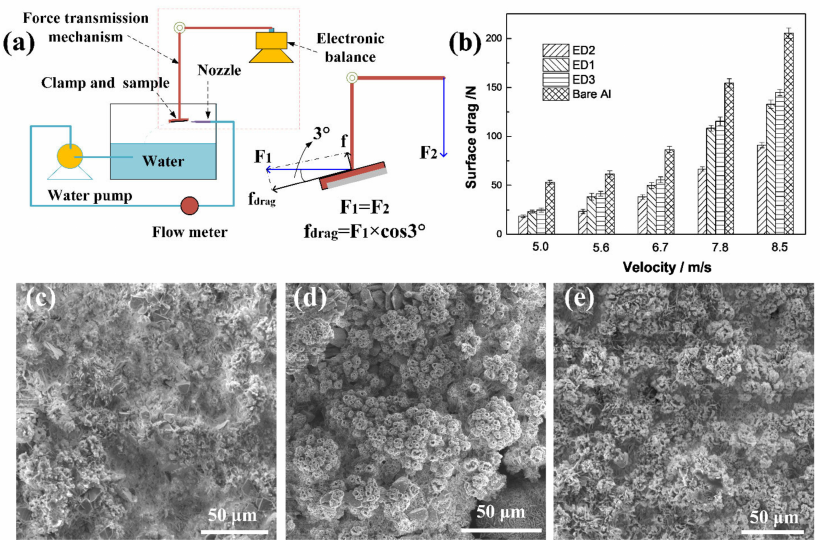
Figure 9. The schematic of the drag reduction apparatus and the results: ( a ) schematic of the drag reduction apparatus; ( b ) drag reduction results of different samples; ( c ) morphology of ED1 sample after drag reduction test; ( d ) morphology of ED2 sample after drag reduction test; ( e ) morphology of ED3 sample after drag reduction